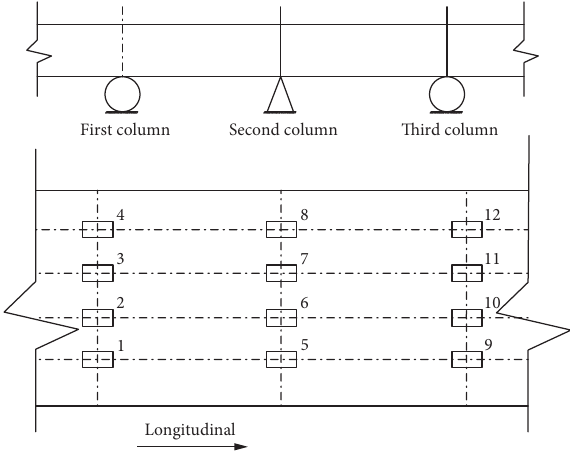
Figure 17: Arrangement of bearings. Table 5: Vertical force of bearings of Shangban Bridge (without influence of